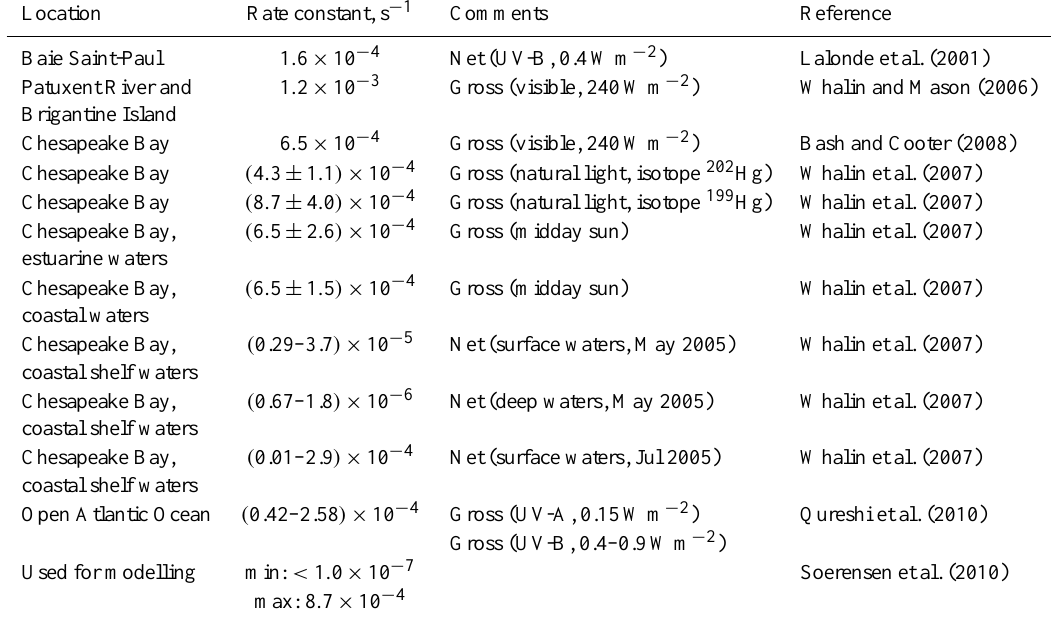
Table 1. Rate constants of mercury photochemical reduction in seawater.